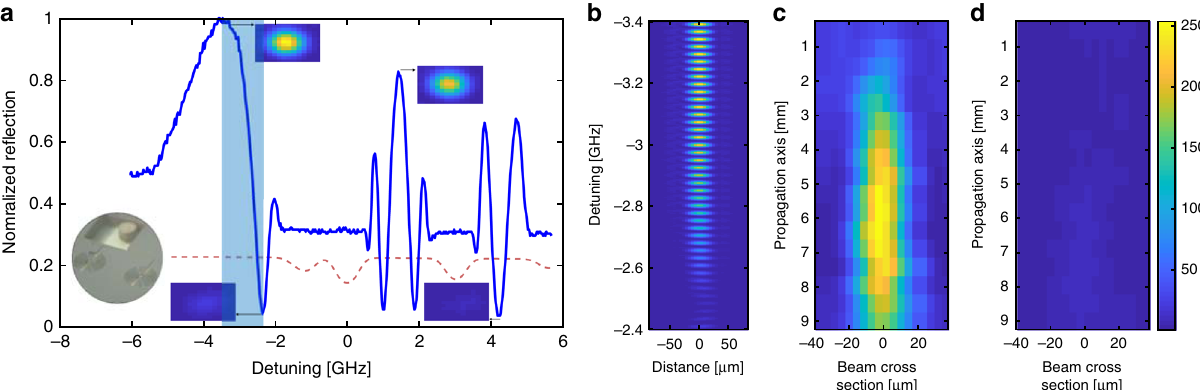
Fig. 3 Atomic Fresnel lens spectroscopy and characterization. a Fresnel lens spectrum at the focal point, obtained by post processing a set of recorded CCD images while simultaneously scanning the lasers frequency. Inset images are examples of such images at different frequency detunings. An additional inset shows a zoomed photograph of the actual device. b A series of CCD images recorded at the focal plane corresponding to the maximal position with detuning of − 3.4 GHz to the minimal point with detuning of − 2.4 GHz. c , d The spatial dependence of the focal point cross-section as function of the propagation axis plotted for the two extreme ( c ) on and ( d ) off states. Scale bar refers to fi gures b – d and is in units of normalized re fl ected power